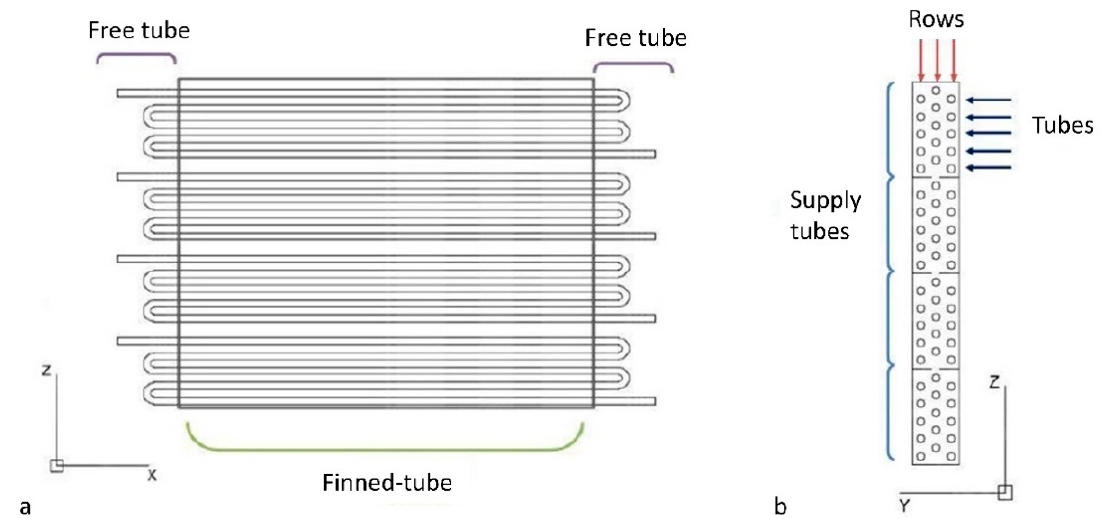
Figure 6. Schematic structure of the sub-element tubes: ( a ) front view of the tubes, highlighting both the free tube part (without fins, on the supply and discharge side if the heat exchanger) and the finned-tube part (with fins, in the middle of the heat exchanger); ( b ) side view of the tubes highlighting the arrangement of the four supply tubes with three rows and five tubes for each row. The refrigerant flows inside the tubes along the x-direction. The air flows through the heat exchanger along the y-direction. The supply tubes are arranged along the z-direction.